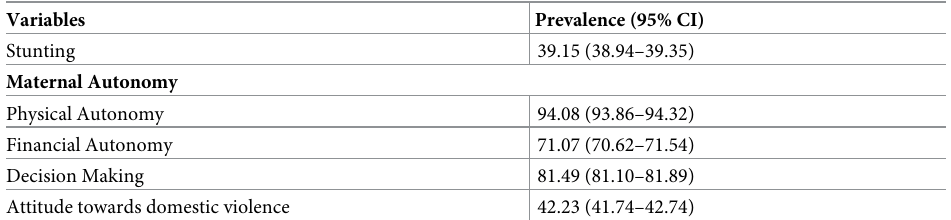
Table 1. Prevalence along with 95% CI.